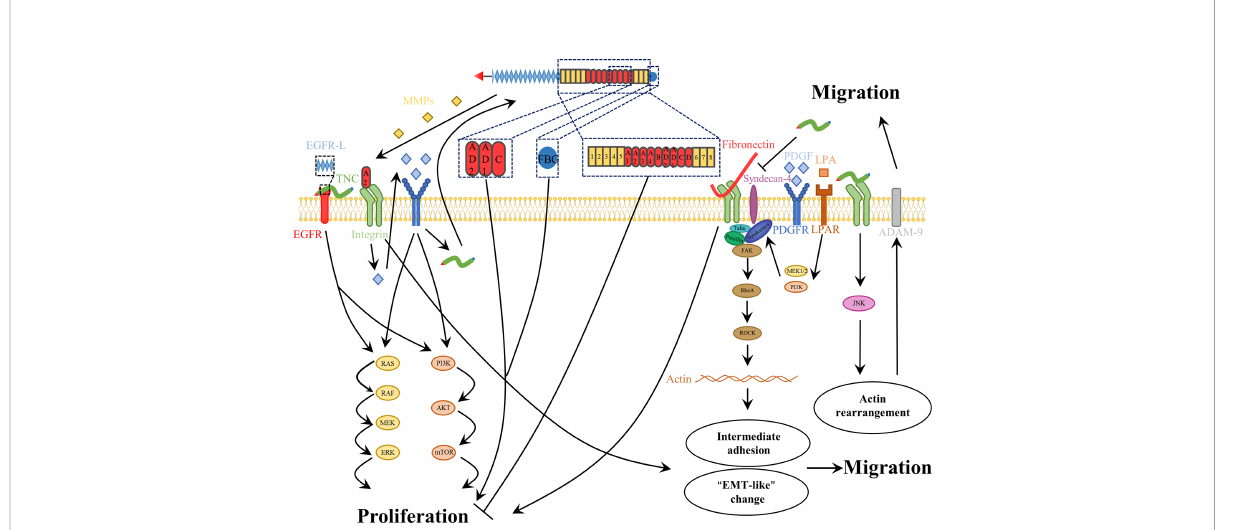
FIGURE 4 The roles of TNC in glioma cell proliferation and migration. For one thing, the role of TNC in glioma cell proliferation is complex. The EGF-like repeats, the FBG region, A2 and some alternatively spliced domains, such as AD1, -AD2 and -C, of TNC as well as integral TNC molecule contribute to the glioma cell proliferation. In contrast, the fragment composed of all FNIII-domains decreases the proliferation of glioma cell. In addition, TNC impairs the adhesive properties of FN, which contributes to glioma cell proliferation. For another thing, TNC promotes glioma cell invasiveness. This molecule not only contributes to the intermediate adhesion that support cell motility, but also promotes “ EMT-like ” changes. Moreover, TNC also induces matrix destructing enzymes to promote tumor cell